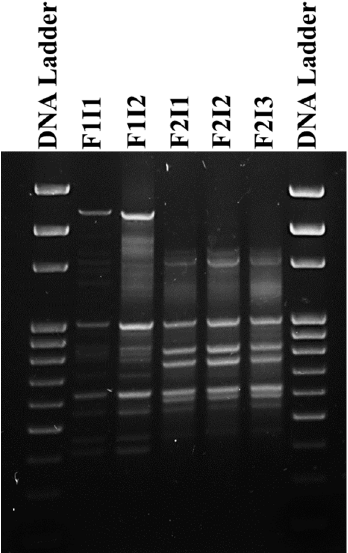
Figure 1. BOX-PCR analysis of the mcr-1 -positive E. coli . The analysis revealed that the 5 isolates belonged to two distinct fingerprint profiles that were classified as F1 and F2. Isolates are designated by the letter I.